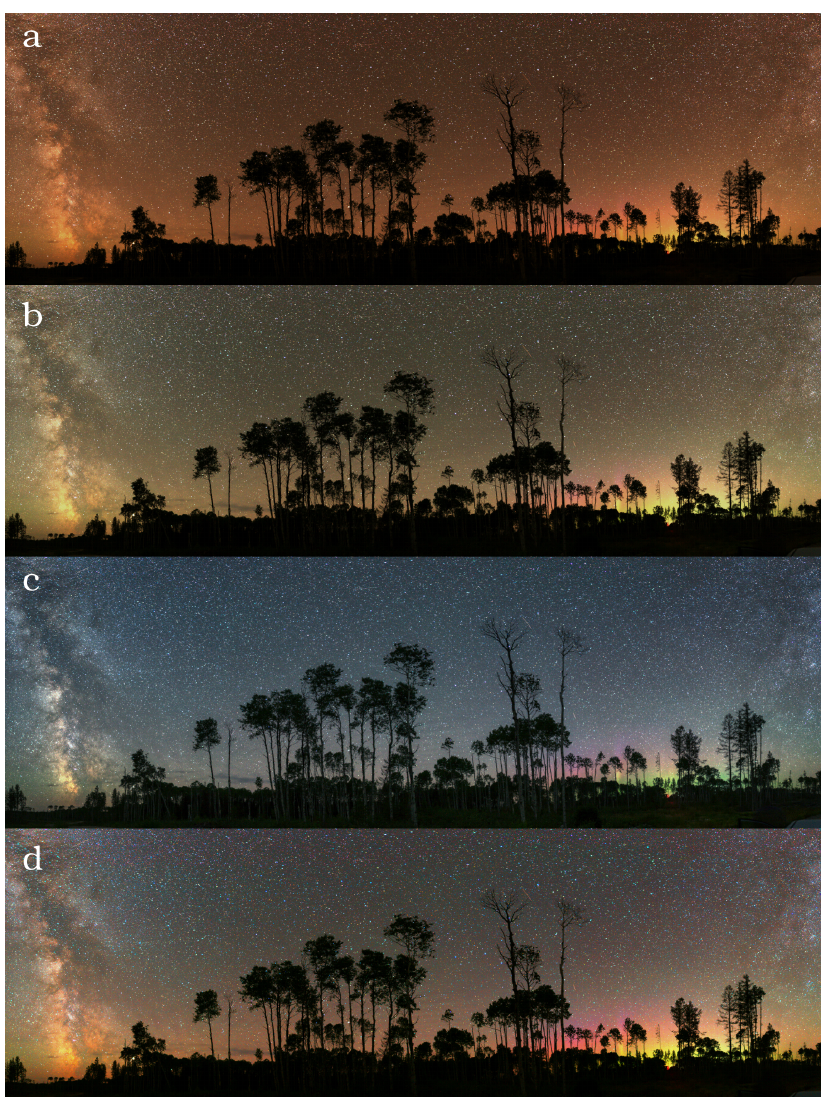
Figure 8. Different representations of the same photo taken at a light pollution free location in Ontario, Canada (the coordinates are presented in the text). ( a ) real colours ( b ) 3800 K white balance setup, ( c ) manual additional processing, and ( d ) false colour